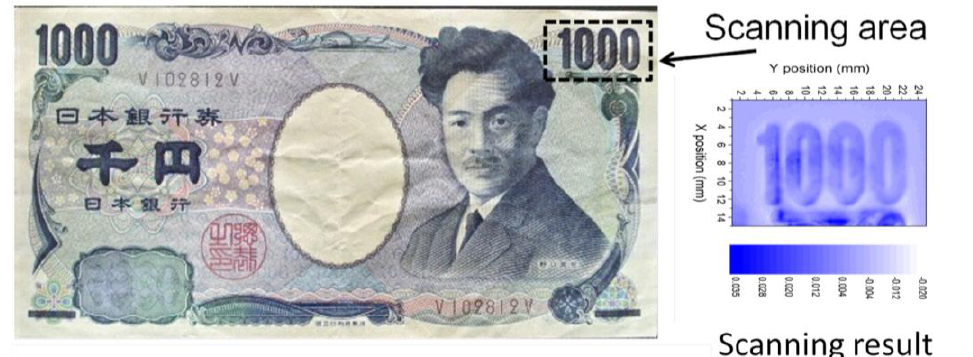
Figure 5. Scanning result of Japanese thousand bill using the magnetic